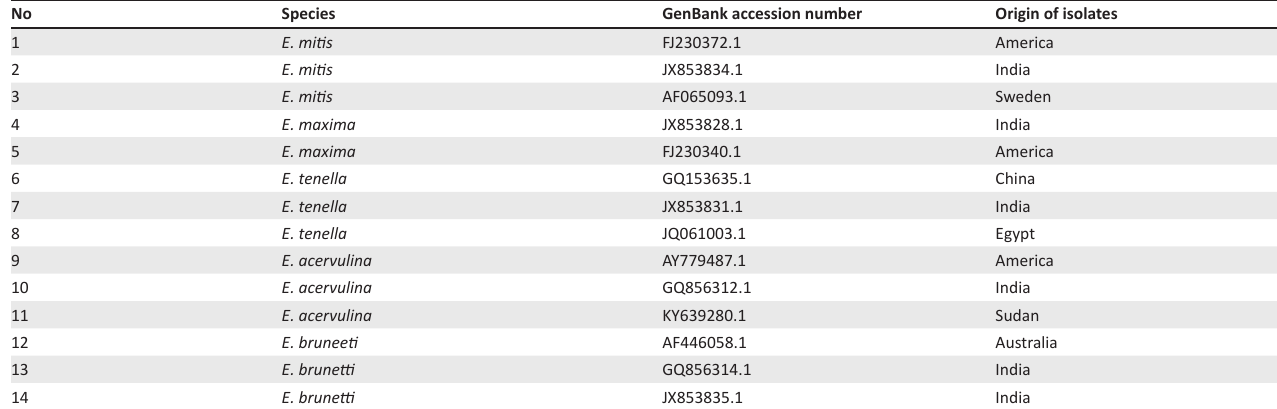
TABLE 4–A1: ITS-1 sequences of Eimeria species downloaded from GenBank.